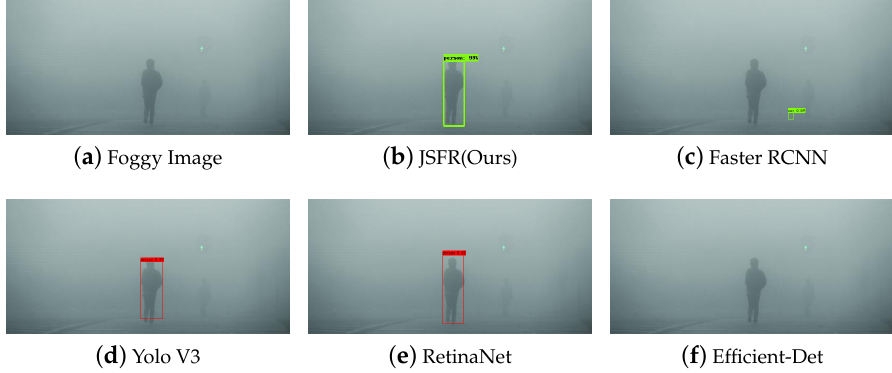
Figure 12. Testing results on RTTS for JSFR and object detection methods including Faster RCNN , Yolo V3 , RetinaNet , and Efficient-Det (electronic zoom-in recommended).